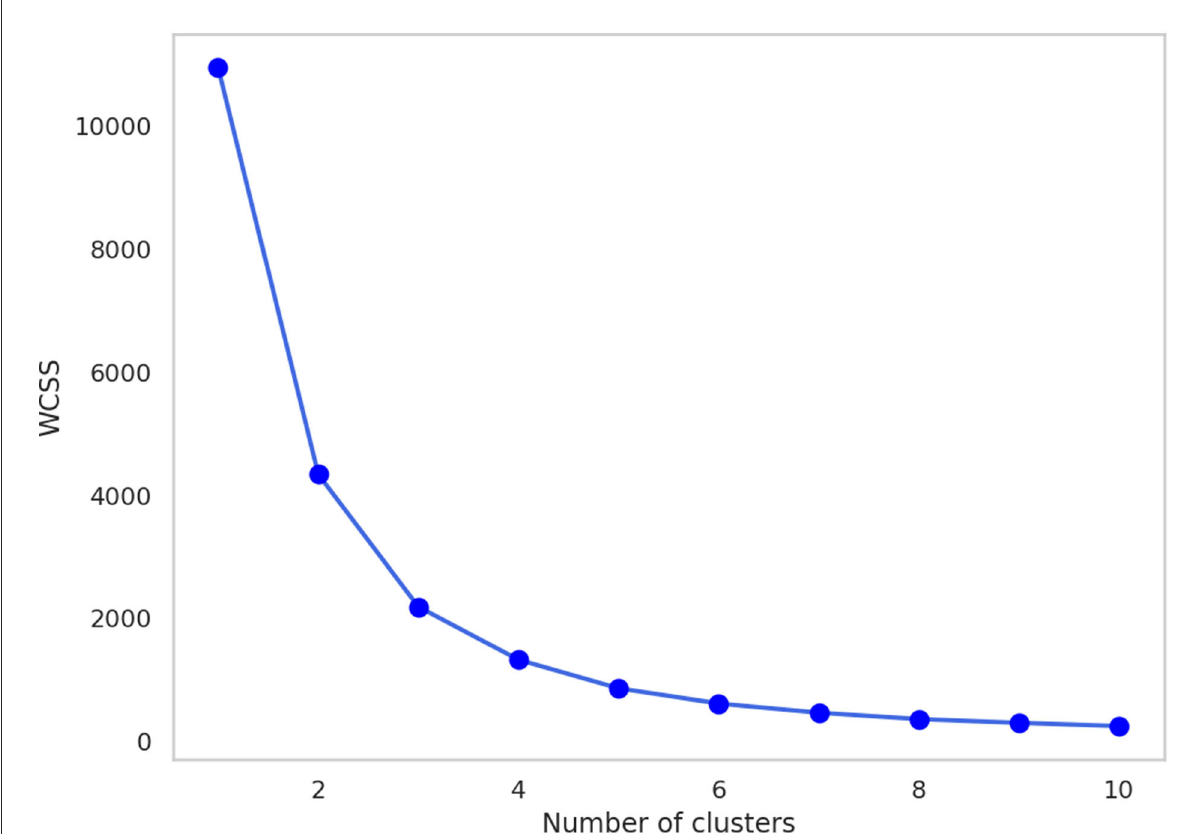
FIGURE6 The change in WCSS with the number of clusters after feature extraction by the deep autoencoder ( J = 2). WCSS, within-cluster sum of squares.